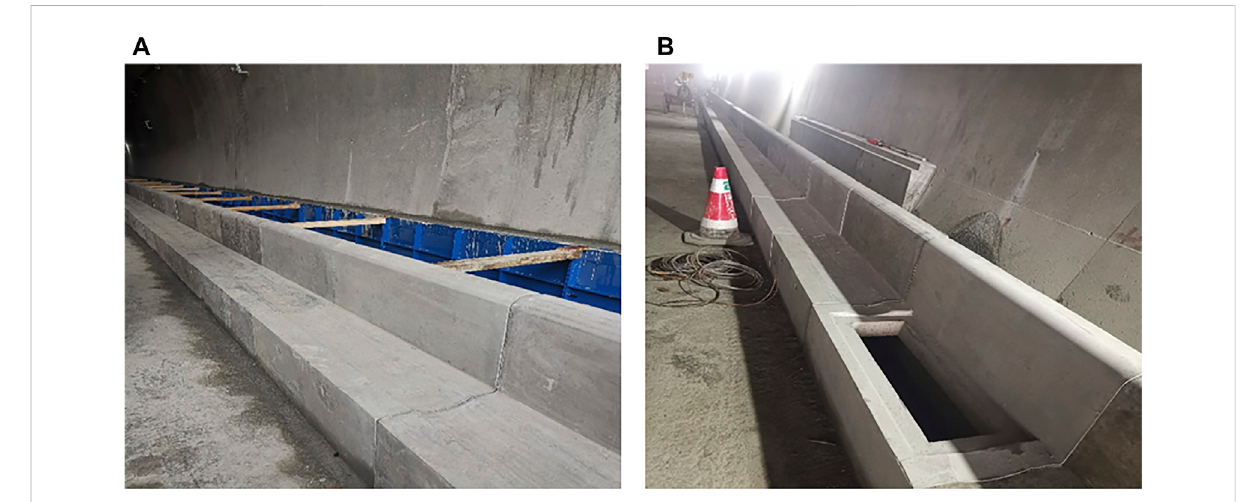
FIGURE 10 Pictures of prefabricated curb components at a construction site: (A) side ditches and side stones, (B) sand sediment